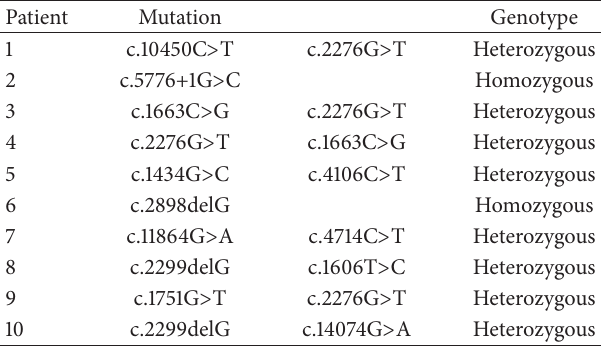
Table 1: USH2A gene mutations in our Usher patients